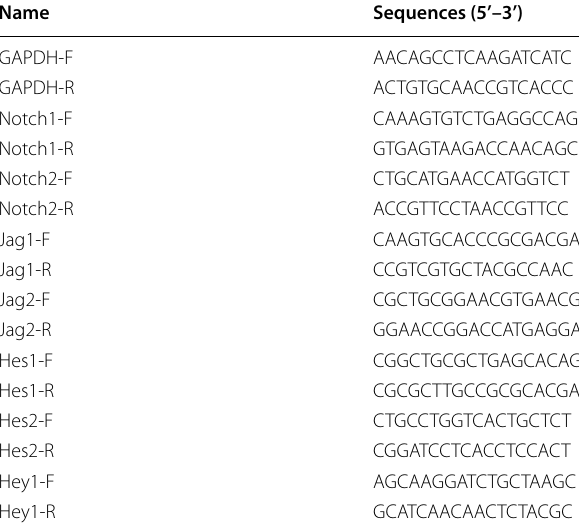
Table 2 Primers used for